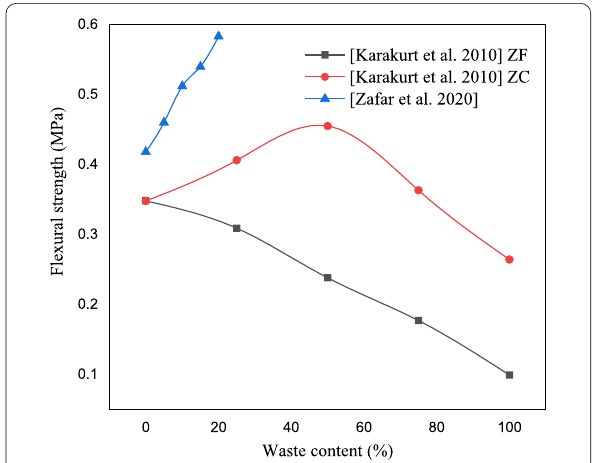
Fig. 9 Flexural strength of AAC on the addition of various